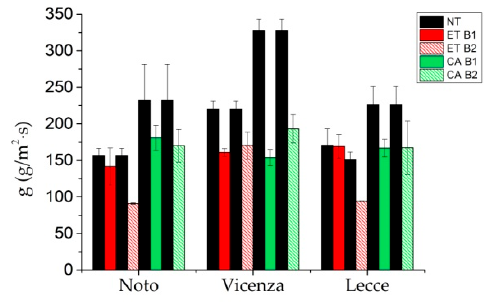
Figure 7. Water vapor permeability test results expressed as water vapor permeability coefficient (g) reported as a comparison before (NT = untreated) and after treatment.